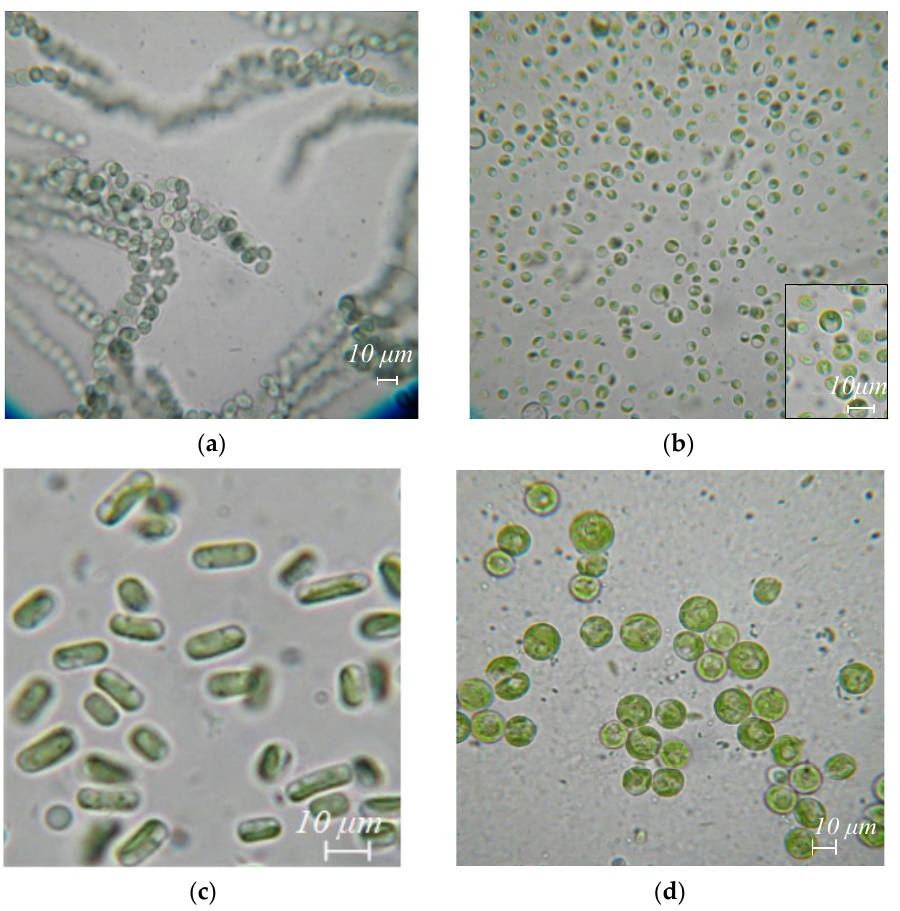
Figure 2. Algae species extracted from body surface and gut washes, and excretions of R. kessleri : ( a ) Nostoc sp., ( b ) Chlorella vulgaris , ( c ) Stichococcus bacillaris , ( d ) Vischeria magna .